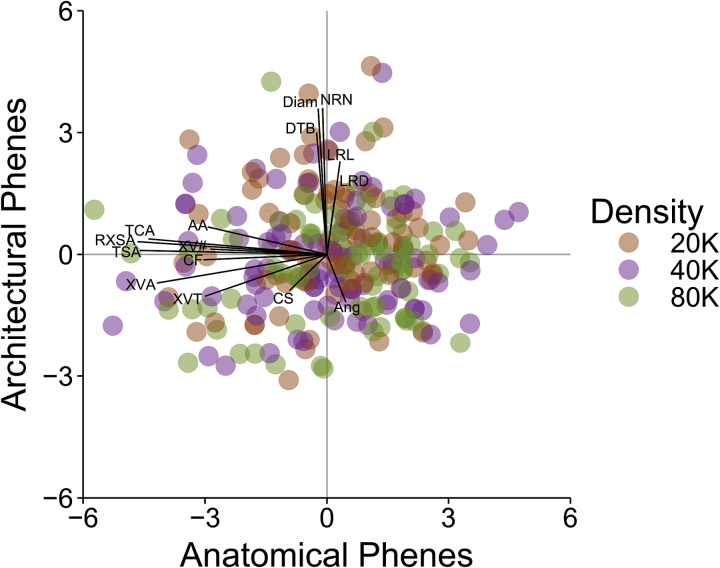
Principal component analysis of crown root architectural and anatomical phenes conducted on raw data (n=261, must omit an entire row when any measurement is missing). Points represent the scores of PC1 and PC2 for the individual root crown samples. Labelled lines demonstrate the correlation of phene values to principal component scores (maximum correlation=0.72). (This figure is available in colour at JXB online.)